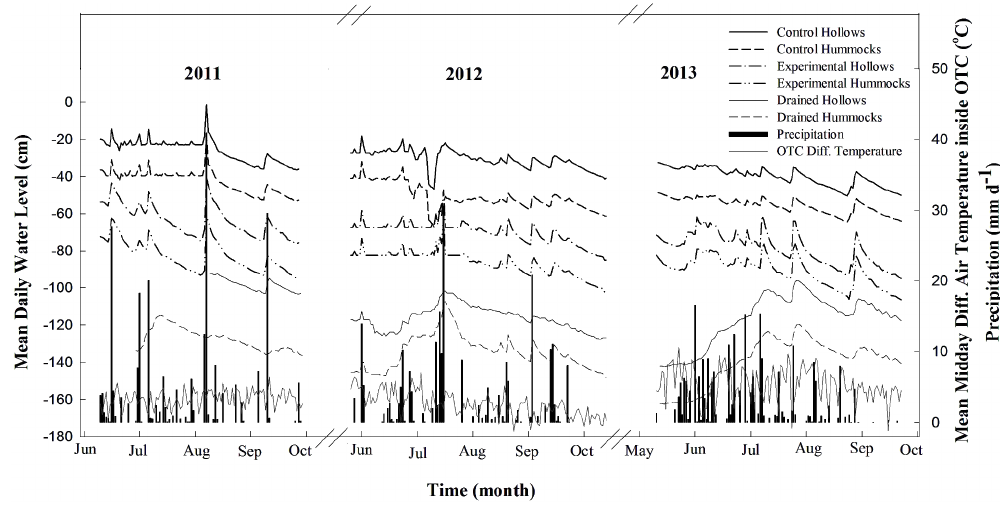
Figure 2. Mean daily water level, midday differential (warmed – ambient) air temperature and precipitation in hummock and hollow micro- forms during growing seasons of 2011, 2012 and 2013. Note the right y axis has two values using the same scale: mean midday differential air temperature and daily precipitation. The x axis 2011, 2012 and 2013 separately. The partially missing water level data at drained hum- mocks in 2011 were due to levelogger’s malfunction. The cumulative seasonal precipitation during 2012 and 2013 was 30.0 and 35.3% less, respectively, than that in